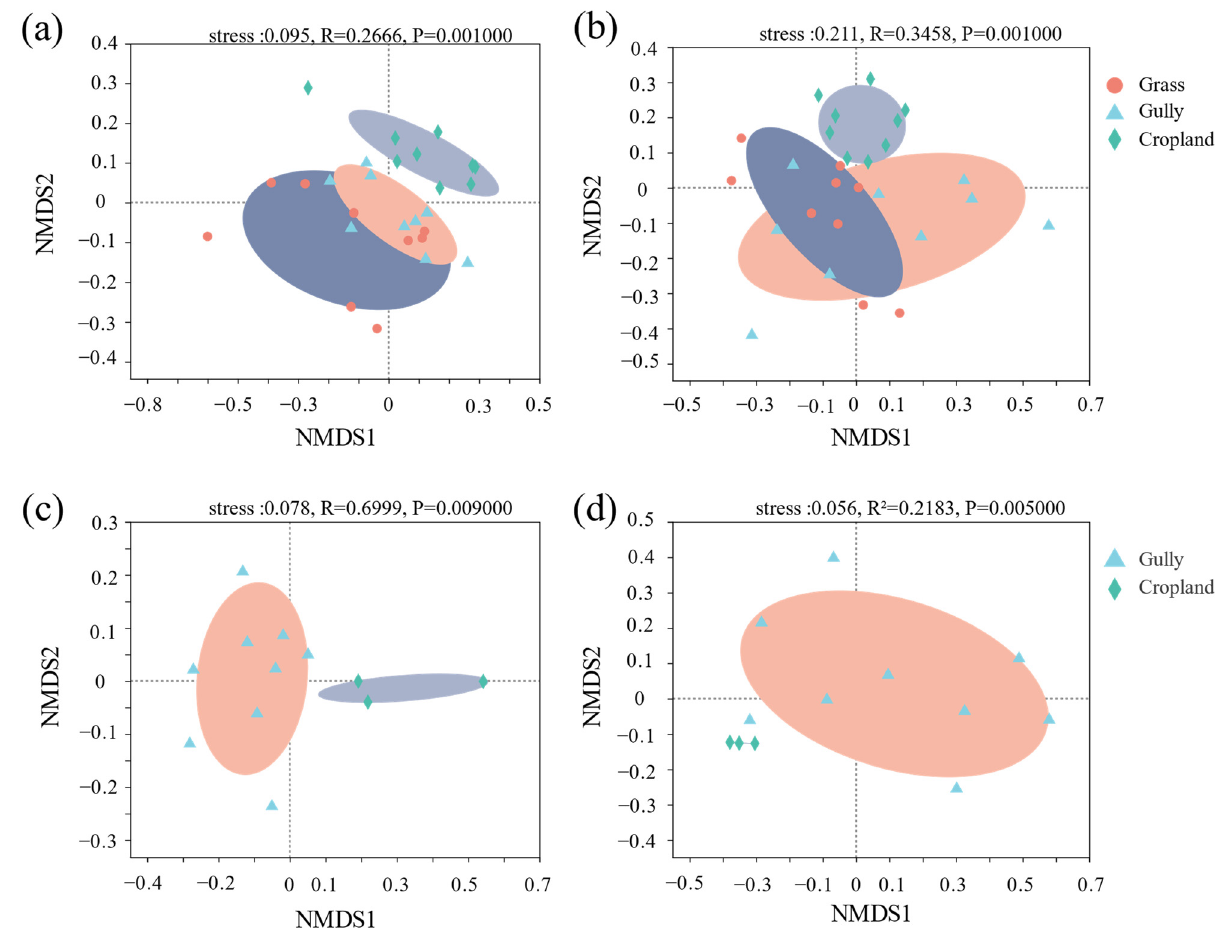
Figure 2. Soil bacterial and fungal community composition affected by natural vegetation restoration and land use types at the Guangrong and Yanmagou sites. Non-metric Multidimensional scaling analysis (NMDS) plot based on the Bray-Curtis distances of bacterial ( a , c ) and fungal ( b , d ) among gully, farmland and deposition area at Guangrong site in 0–60 cm soil depth ( a , b ) and Yanmagou site in 0–20 cm soil depth ( c , d ).